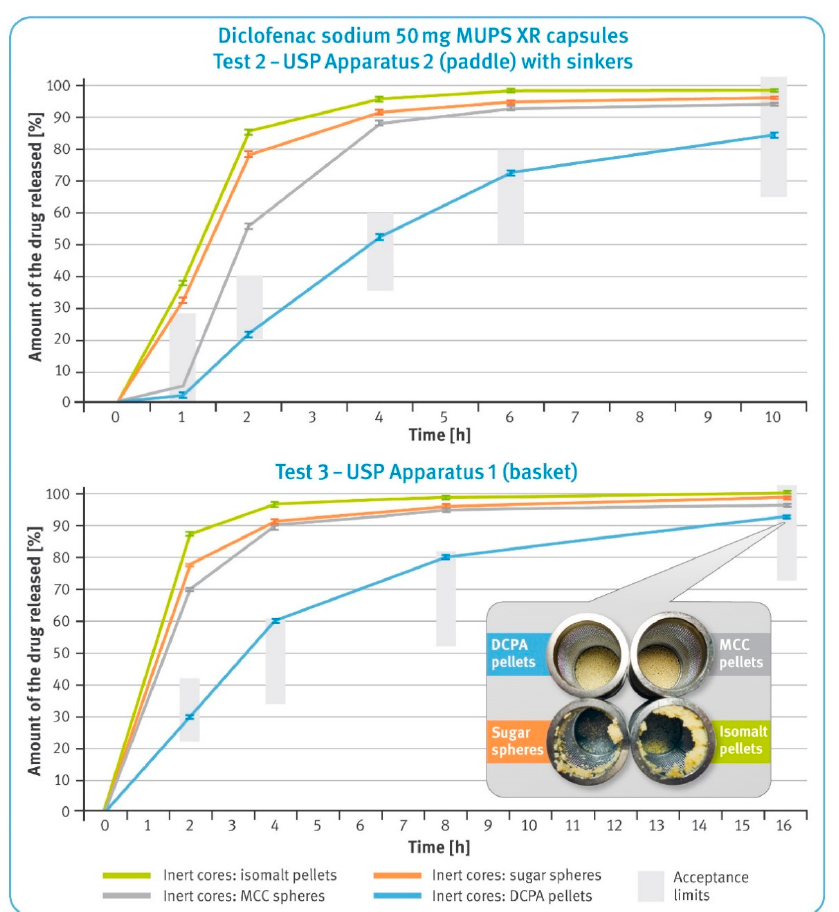
Figure 4. The release of the drug substance from diclofenac sodium 25 mg DR hard gelatin cap- sules: 2 h incubation in 0.1 M HCl (in the smaller box) and in the buffer phase (phosphate buffer solution, pH 6.8) (mean of n = 6, SD is indicated by the error bars).